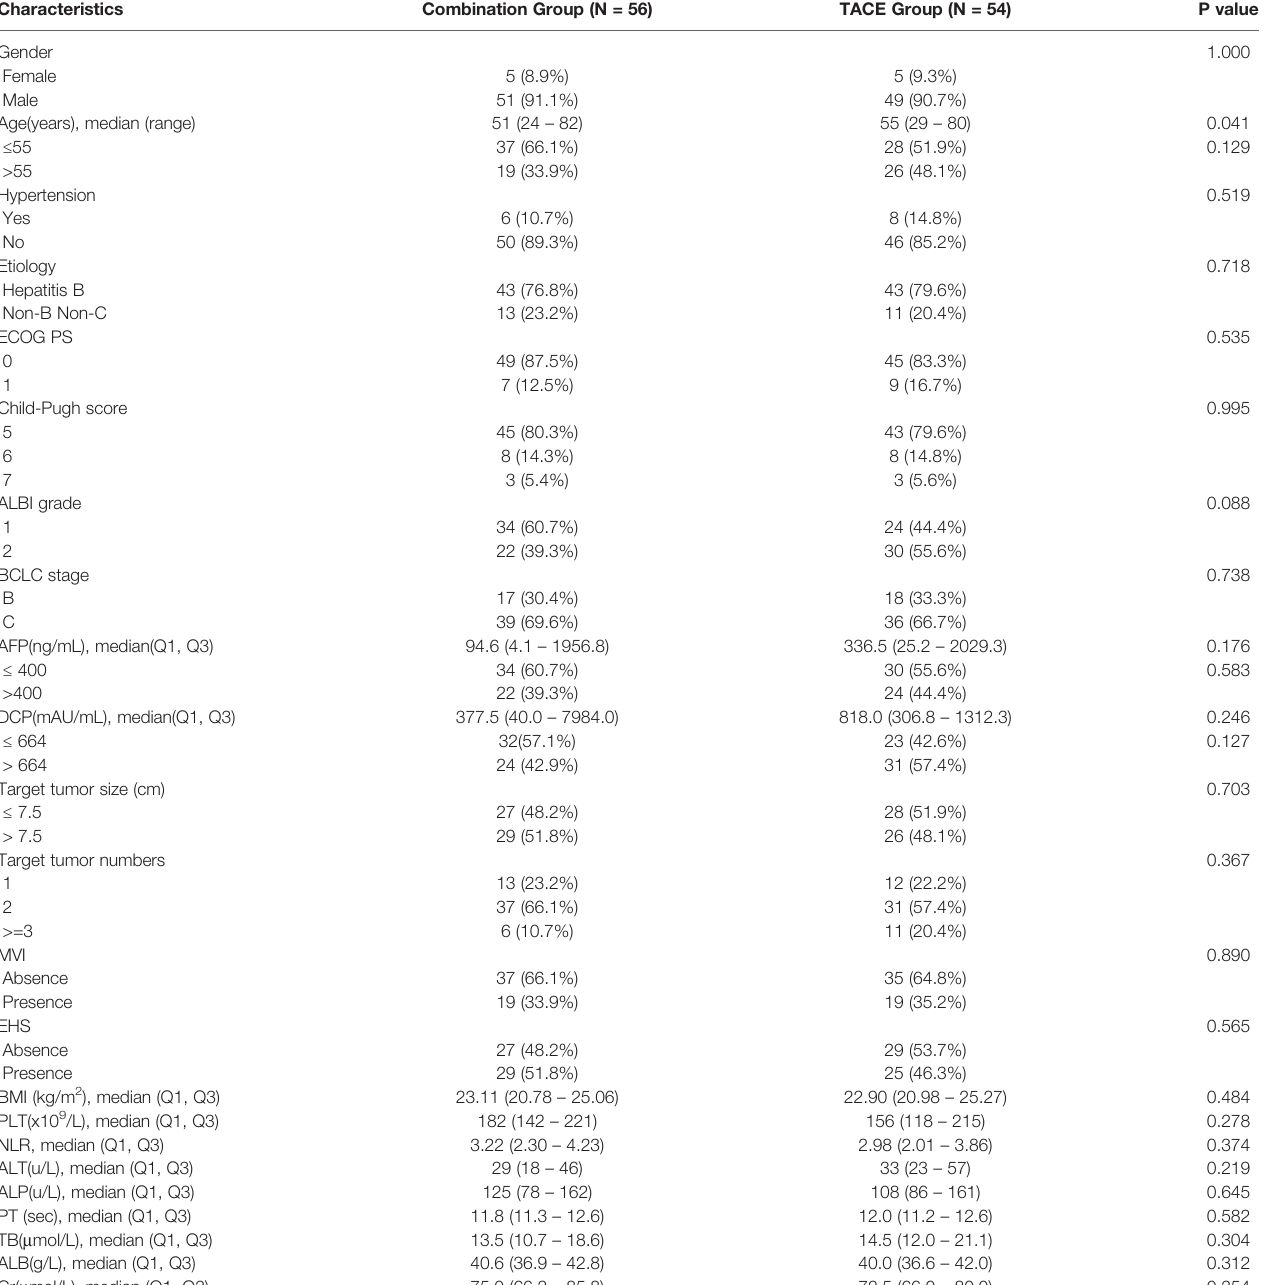
TABLE 1 | Baseline demographic and clinical characteristic of enrolled patients.